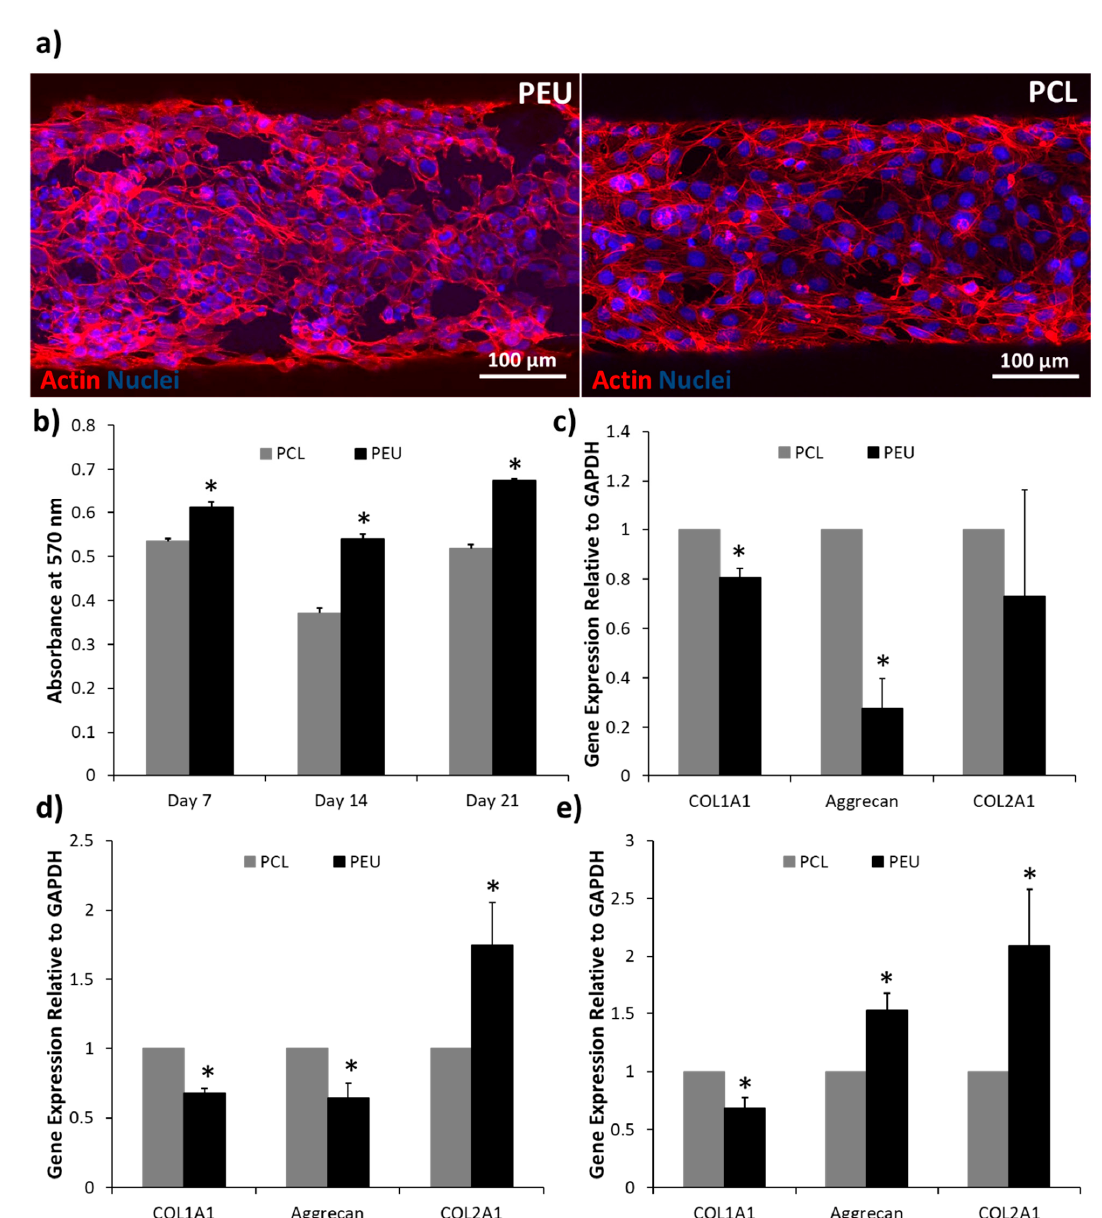
Figure 6. The biological response of TC28a2 human chondrocytes to PEU and PCL scaffolds. ( a ) Fluorescence confocal microscopy images of chondrocytes seeded onto PEU/PCL scaffolds and stained with phalloidin (actin) and DAPI (nuclei); ( b ) absorbance at 570 nm of chondrocyte culture media treated with 0.1 mg/mL resazurin after 7, 14 and 21 days on PEU and PCL scaffolds; ( c – e ) relative expression of COL1A1, aggrecan and COL2A1 by chondrocytes seeded on PEU and PCL scaffolds at day 7, 14 and 21, respectively (* indicates p <0.05, PEU vs. PCL; error bars represent standard error of the mean, n = 3).